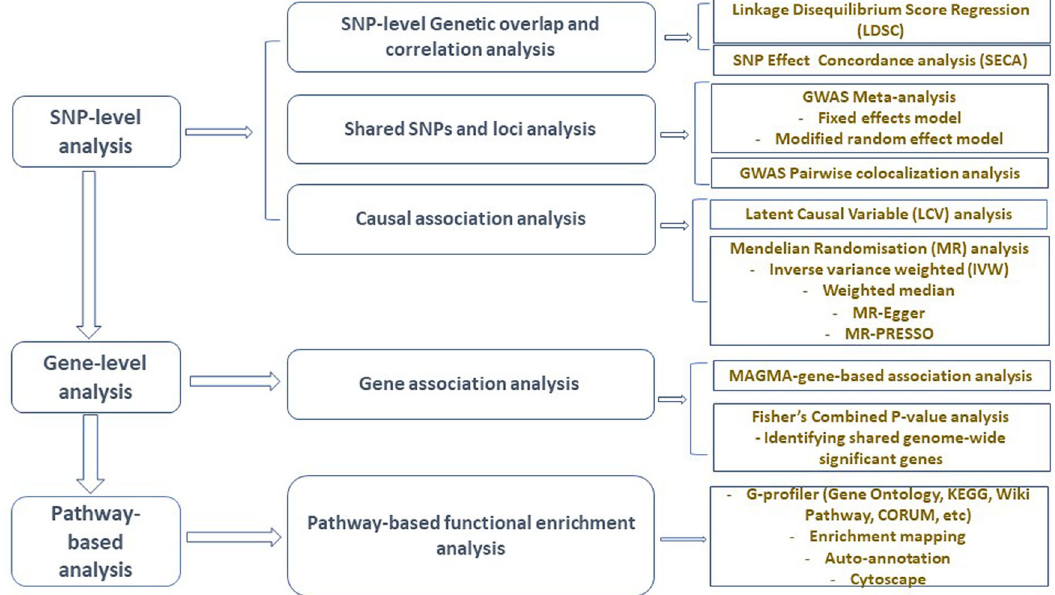
Fig. 1 Study design and work fl ow: examining shared genetic and causality of GIT disorders with the risk of Alzheimer ’ s disease. GWAS genome-wide association studies, SNP single-nucleotide polymorphism, SECA SNP effect concordance analysis, LDSC linkage disequilibrium score regression, LCV latent causal variable, MAGMA multi-marker analysis of genomic annotation, MR Mendelian randomisation, MR-PRESSO Mendelian randomisation pleiotropy residual sum and outlier, KEGG Kyoto Encyclopedia of Genes and Genomes.